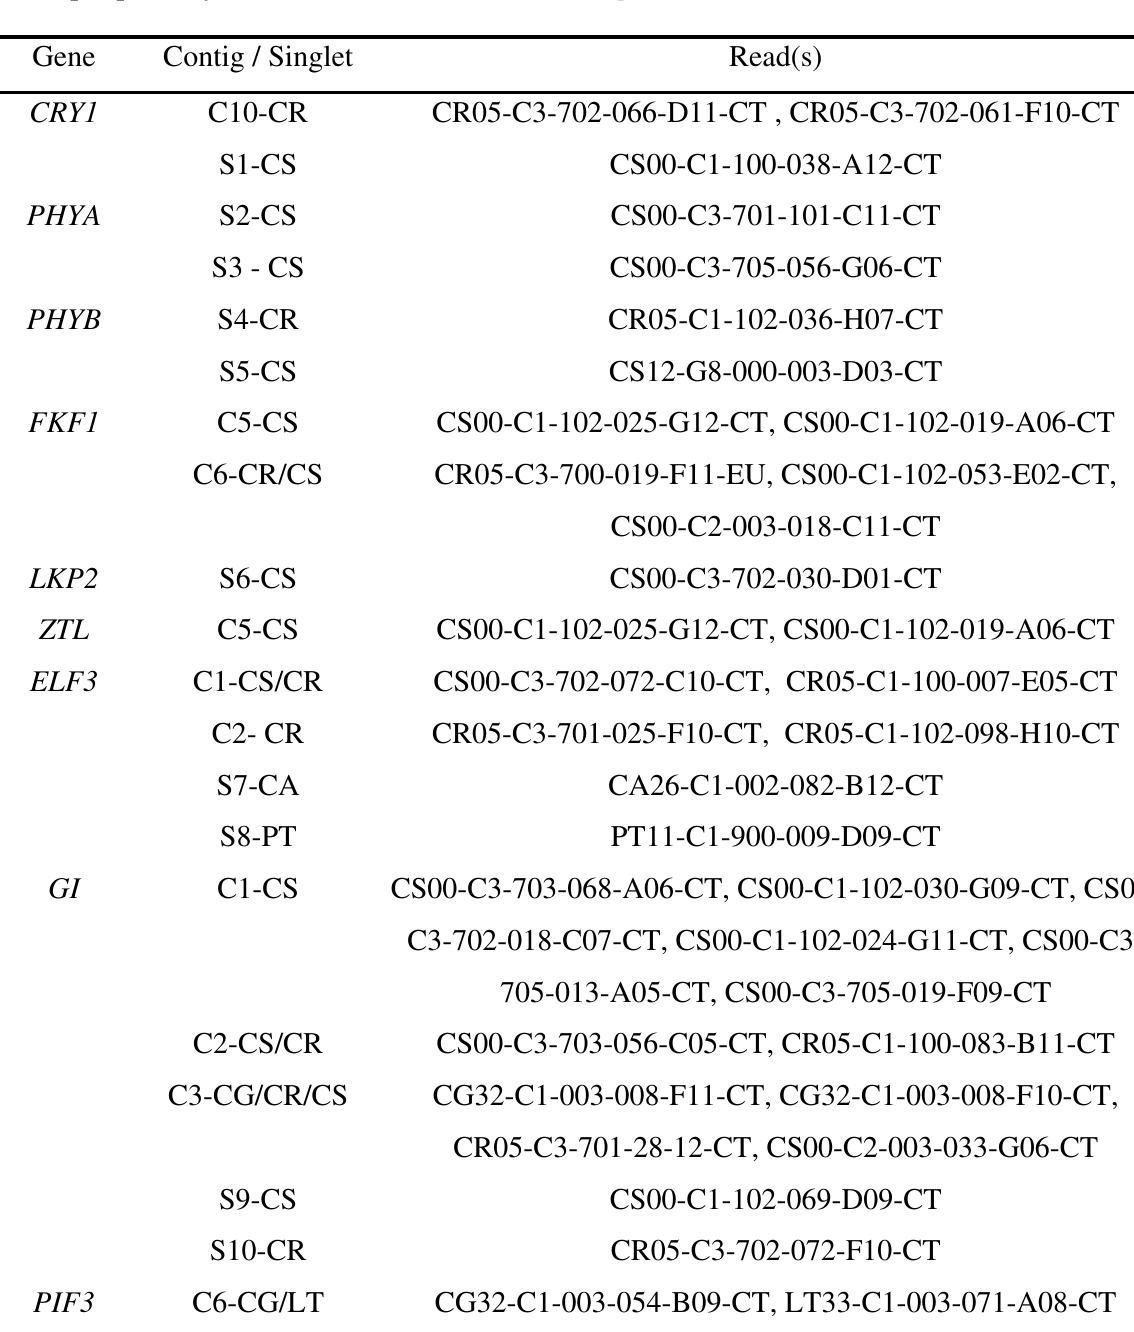
Table 1S - Citrus reads constituting contigs and singlets with homology to genes involved in the input pathway to the circadian clock in Arabidopsis thaliana